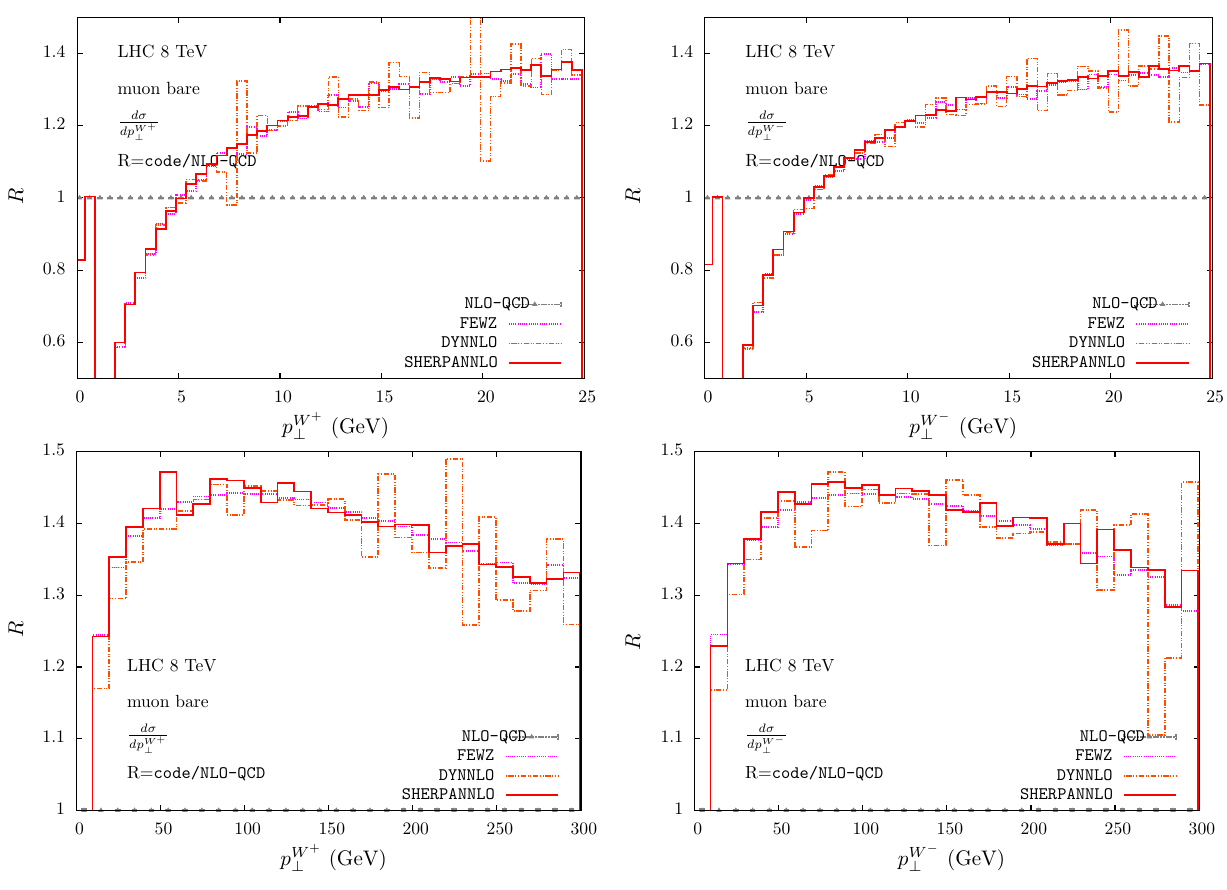
Fig. 18 NNLO QCD effects, expressed in units of NLO QCD, in pp → μ ± ν μ + X ,inthe benchmark setupwithATLAS/CMScutsatthe 8 TeV LHC, for μ + ν μ ( left plots ) and μ − ¯ ν μ ( right plots ) final states. Comparison of the lepton-pair transverse momentum distributions in